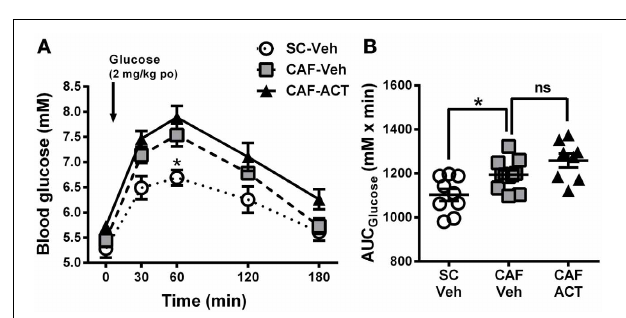
FIGURE 5 | Glucose homeostasis in week 17. (A) Oral glucose tolerance test (oGTT) performed on overnight fasted SC and CAF fed rats treated with Veh or ACT. Whole blood glucose was measured before (0min) and at the indicated time points after the oral (po) administration of 2mg/kg glucose (arrow). ∗ p < 0 . 05 vs. CAF-Veh at the indicated time point by post-hoc test following ANOVA. Mean ± s.e.m. ( n = 8–11) per group. Due to an incomplete blood sample set, data from one SC-Veh and one CAF-Veh rat had to be omitted because of repeated measures within subjects